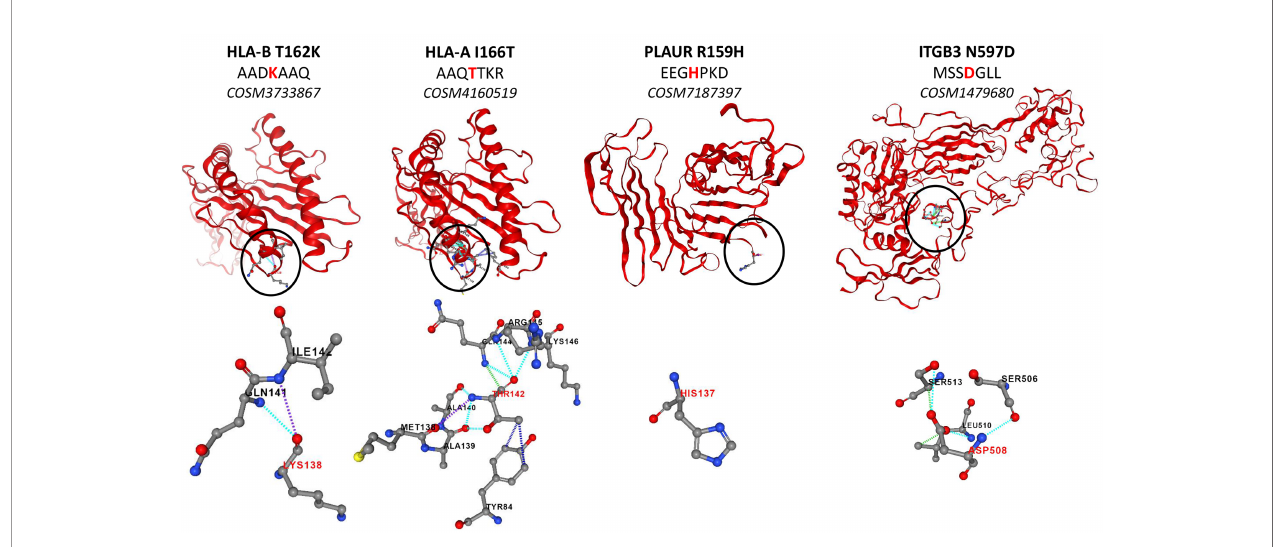
FIGURE 4 | Structure of mutated proteins according to PremPS.